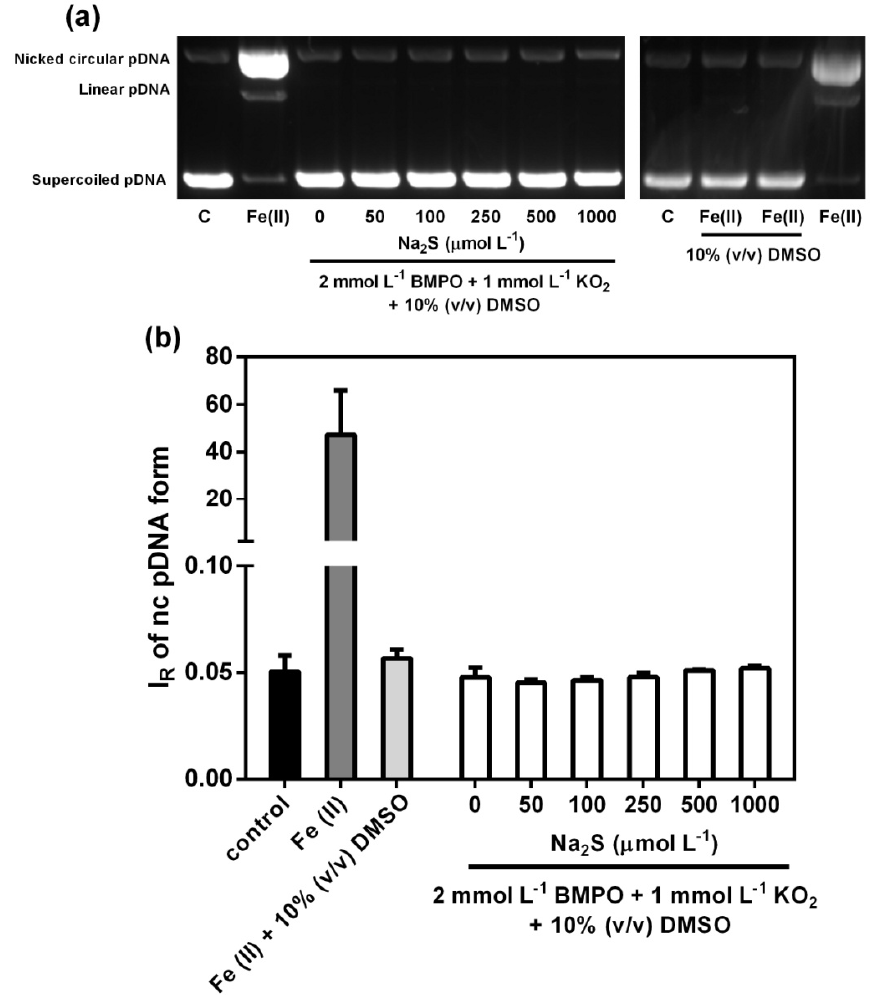
Figure 6. E ff ect of BMPO / KO 2 on pDNA cleavage in the absence and presence of Na 2 S. Representative Figure 6. Effect of BMPO/KO 2 on pDNA cleavage in the absence and presence of Na 2 S. gel ( a ) and column graph ( b ) indicating control (black) and the e ff ects of Fe 2 + (150 µ mol L − 1 FeCl 2 ) Representative gel ( a ) and column graph ( b ) indicating control (black) and the effects of Fe 2+ (150 in 25 mmol L − 1 sodium phosphate bu ff er and 50 µ mol L − 1 DTPA (pH 7.4) without (dark) and with µmol L − 1 FeCl 2 ) in 25 mmol L − 1 sodium phosphate buffer and 50 µmol L − 1 DTPA (pH 7.4) without 10% ( v / v ) DMSO (gray) and increasing concentrations of Na 2 S on pDNA cleavage in the phosphate (dark) and with 10% ( v/v ) DMSO (gray) and increasing concentrations of Na 2 S on pDNA cleavage in bu ff er containing 10% DMSO ( v / v ). The band at the bottom corresponds to the circular supercoiled the phosphate buffer containing 10% DMSO ( v/v ). The band at the bottom corresponds to the circular form of pDNA and the less intense band appearing above in the case of Fe 2 + (dark column) represents supercoiled form of pDNA and the less intense band appearing above in the case of Fe 2+ (dark the linear form of pDNA. The top band corresponds to the nicked circular form of pDNA. Values are column) represents the linear form of pDNA. The top band corresponds to the nicked circular form the means ± SEM, n = of pDNA. Values are the means ± SEM, n = 3.